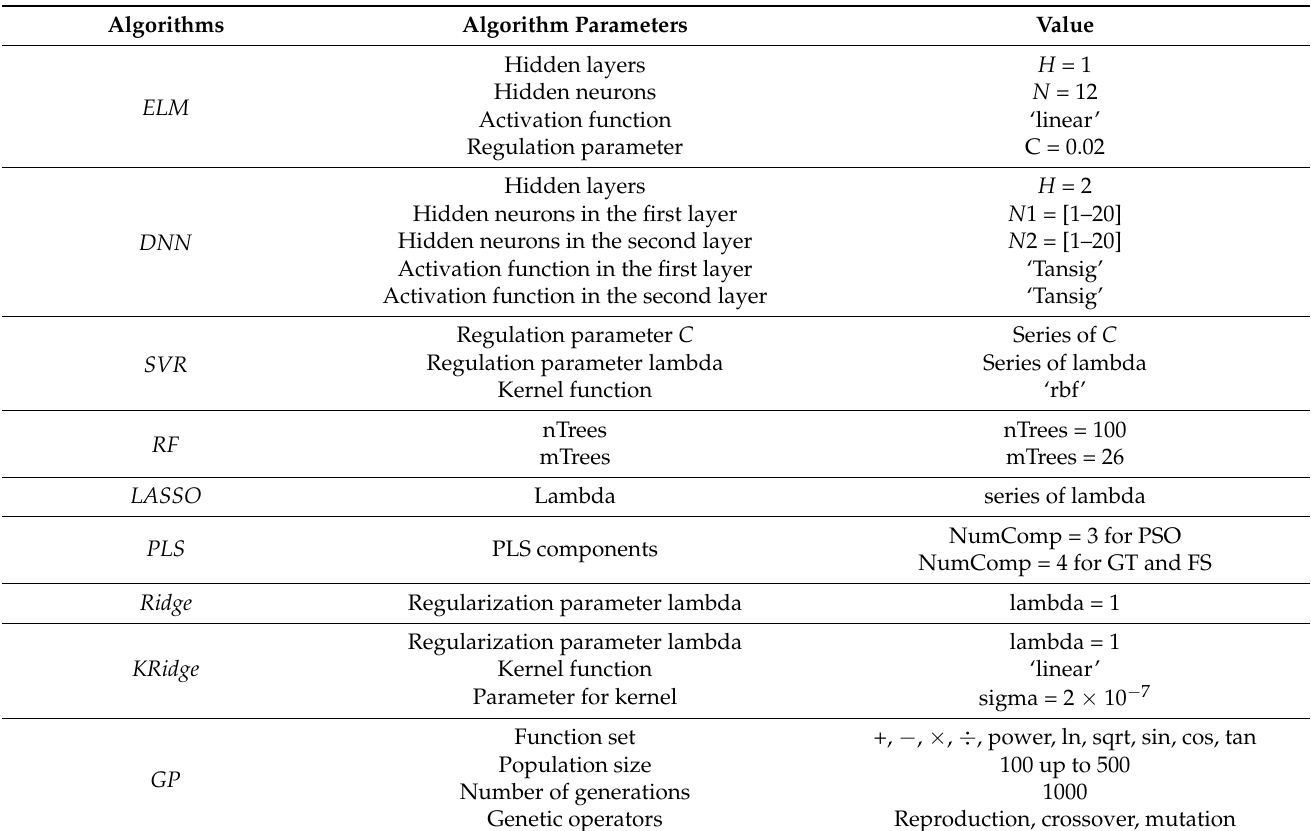
Table 3. Initial parameter settings for the